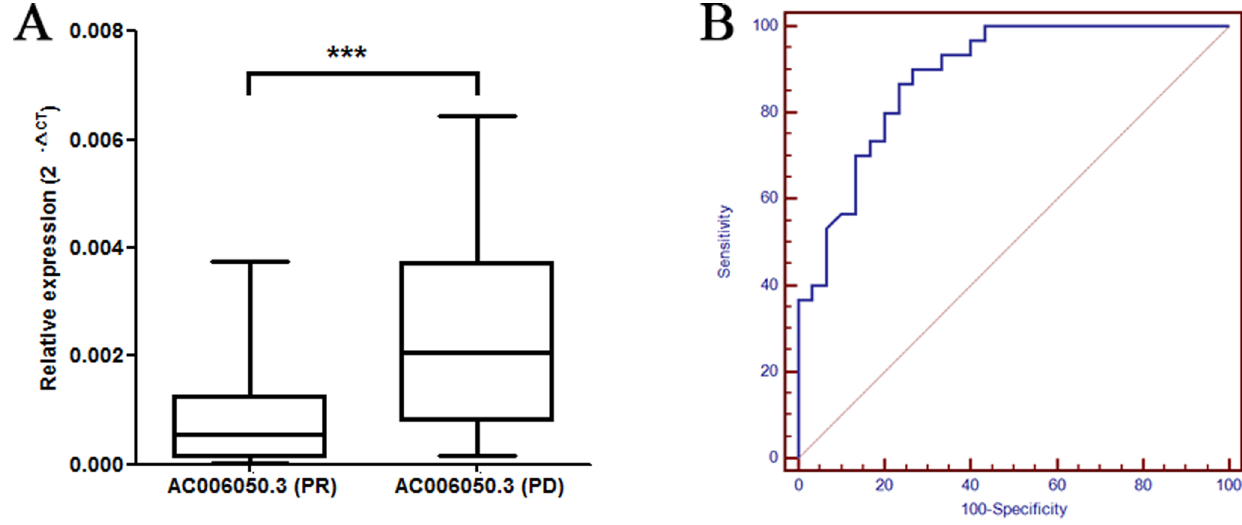
Figure 5. The expression of lncRNA AC006050.3-003 was validated by qPCR in samples of 60 patients with lung SCC stratified according to the chemo response (PR vs. PD) following cisplatin based chemotherapy. (A) lncRNA AC006050.3-003 was aberrantly expressed between PC and PD patients. The term 2 - D Ct was used to describe the relative expression level of lncRNA ( D Ct = Ct target 2 Ct b -actin ). *** P , 0.001 for patients with PD versus patients with PR (Student’s t-test). (B) ROC analysis of the ability of lncRNA AC006050.3-003 levels to discriminate between PR and PD patients with lung SCC receiving cisplatin based chemotherapy.